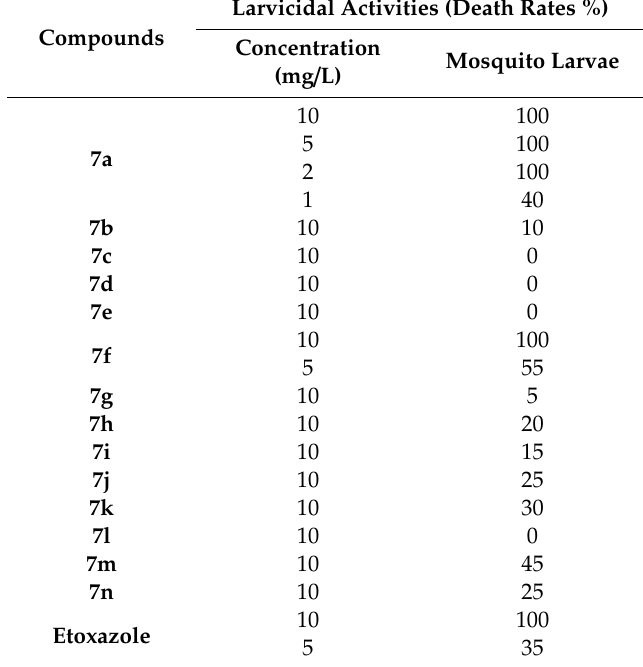
Table 3. Larvicidal activities of title compounds 7a – 7n